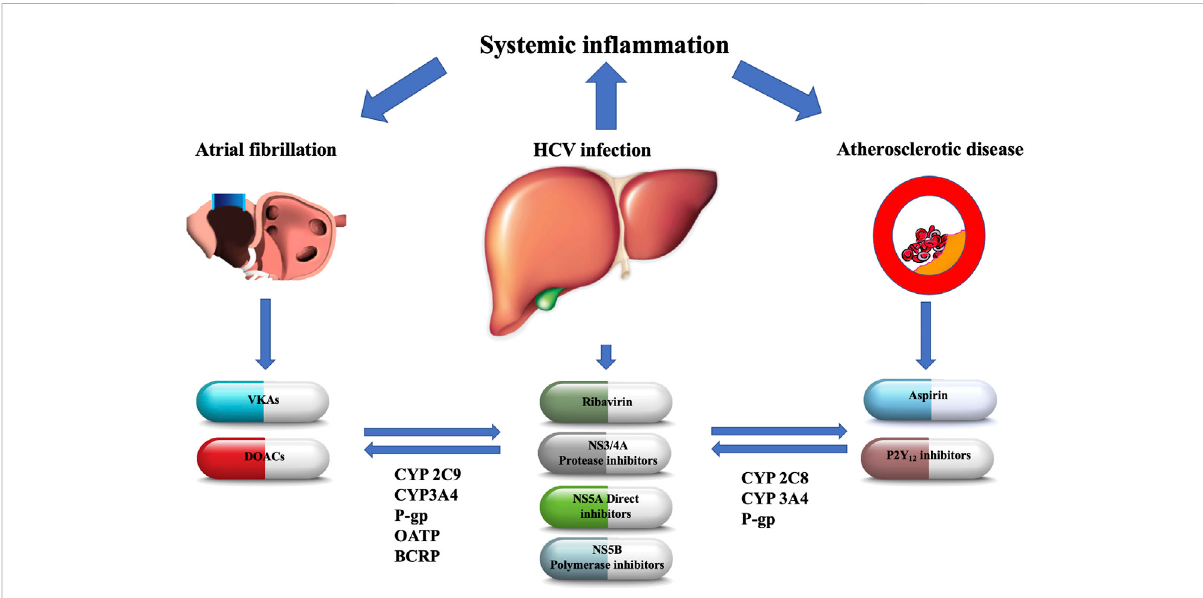
FIGURE 1 The main metabolic pathways of antiviral agents and oral antithrombotic drugs with their potential interactions. NS, nonstructural; CYP, cytochrome P450; P-gp, P-glycoprotein; BCRP, breast cancer resistance protein; OATP, organic anion-transporting polypeptide; VKAs, vitamin-K antagonists; DOACs, direct oral